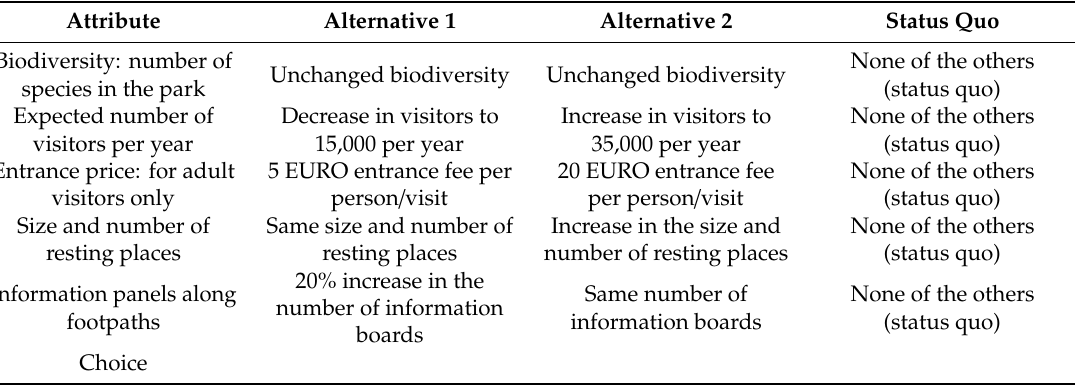
Table 3. Example of a choice